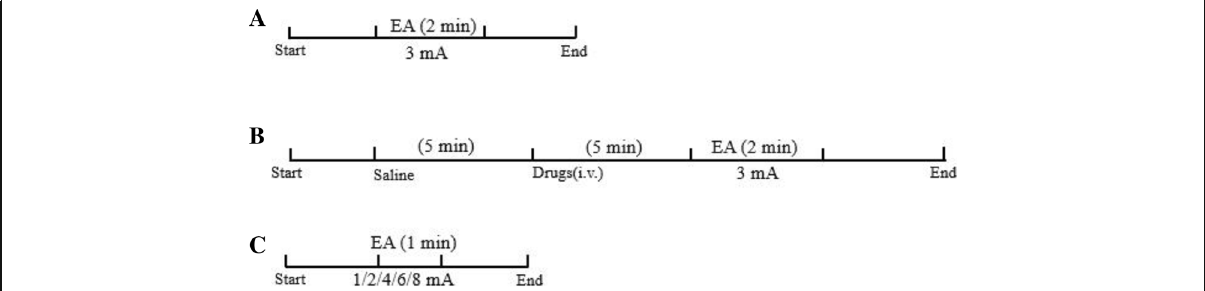
Fig. 1 The experimental procedure. a Intervention timeline in rats stimulated by ordinary EA. b Intervention timeline in rats with drug (clenbuterol, propranolol, acetylcholine or atropine) administration. c Intervention timeline in three kinds of mice (wild-type, β 1 β 2 − / − , M 2 M 3 − / − ) with different intensities of electroacupuncture (1, 2, 4, 6, and 8